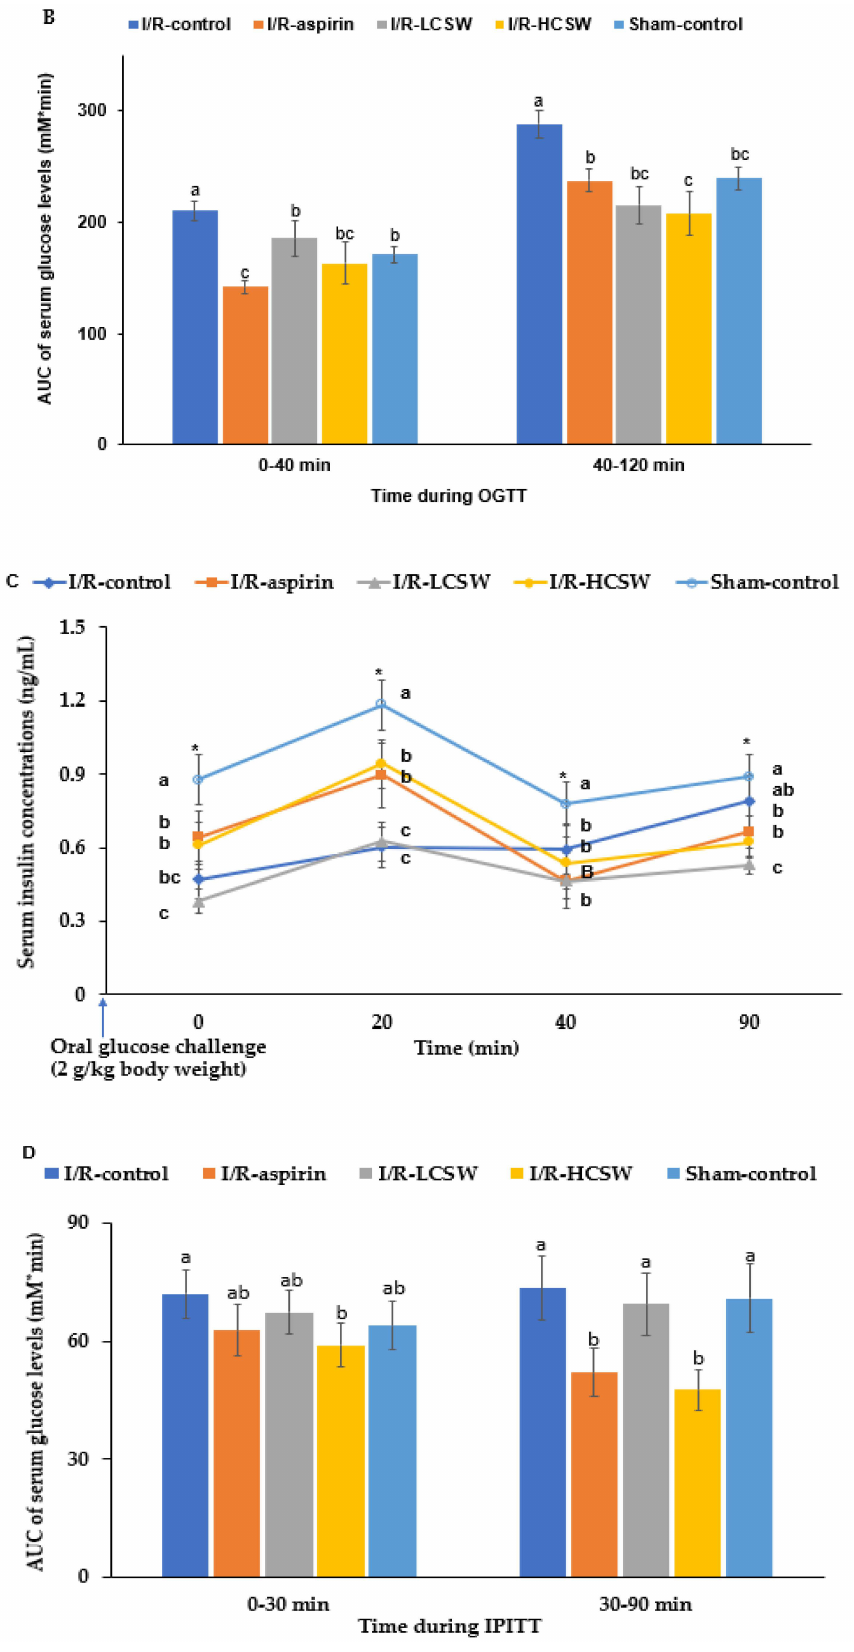
Figure 4. Oral glucose tolerance test (OGTT) and intraperitoneal insulin tolerance test (IPITT). Gerbils that underwent the transient forebrain ischemia by carotid artery occlusion for 8 min and